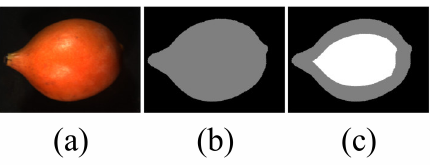
Figure 2. ( a ) RGB image of achacha fruit, ( b ) full mask containing fruit sample and ( c ) eroded mask to define region of interest (ROI) for ripeness evaluation.